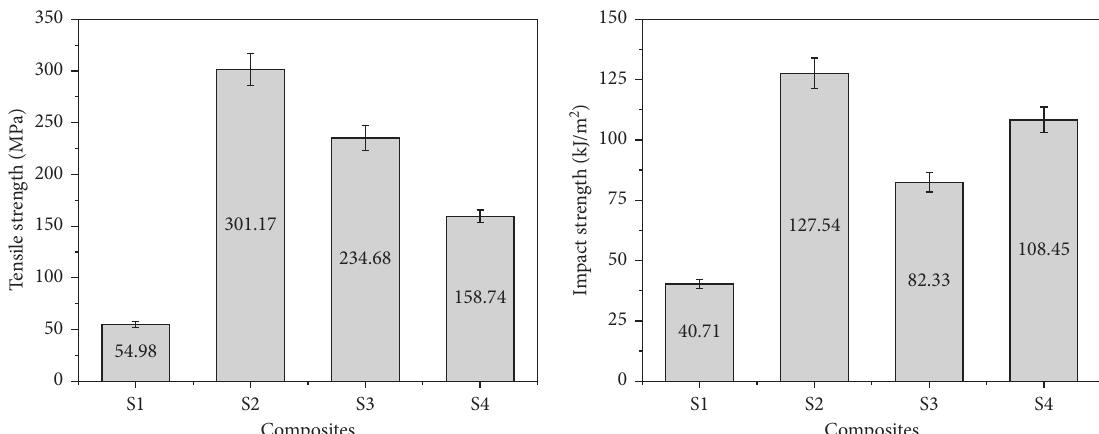
Figure 6: Tensile and impact strength of jute fibre composites (S1), pure carbon fibre composites (S2), jute/carbon/carbon/jute hybrid (S3), and carbon/jute/jute/carbon hybrid (S4)